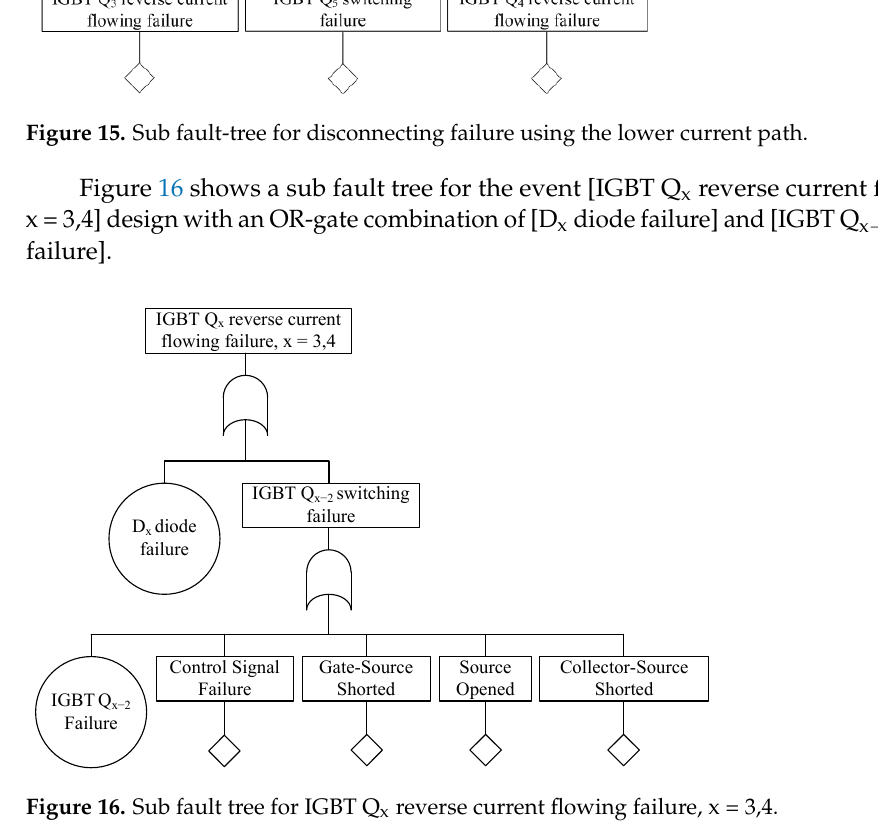
Figure 15. Sub fault-tree for disconnecting failure using the lower current path.